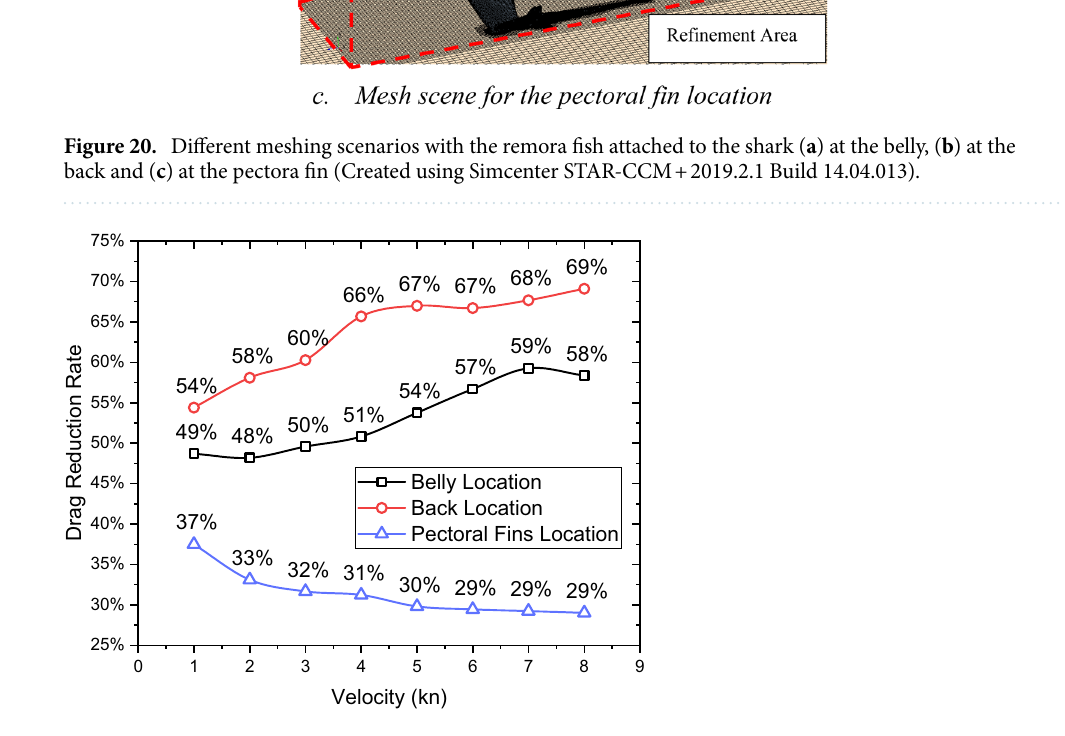
Figure 21. The rate of the drag reduction in a range of velocities when the remora attached on different